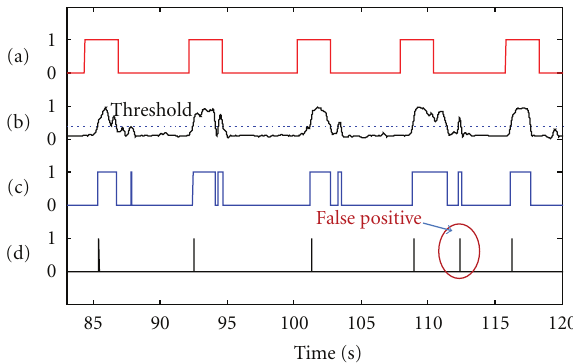
Figure 5: (a) IC intervals or true labels of the signal during 5 trials, (b) the posterior probability of movement class and its threshold, (c) predicted labels, and (d) detected onsets after postprocessing using dwell and refractory